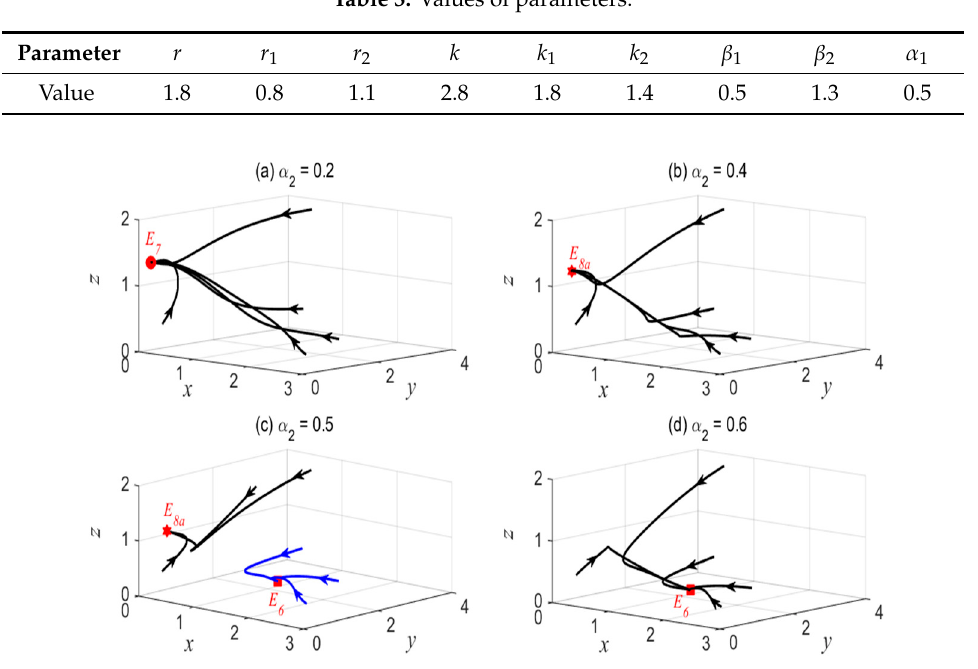
Table 3. Values of parameters.